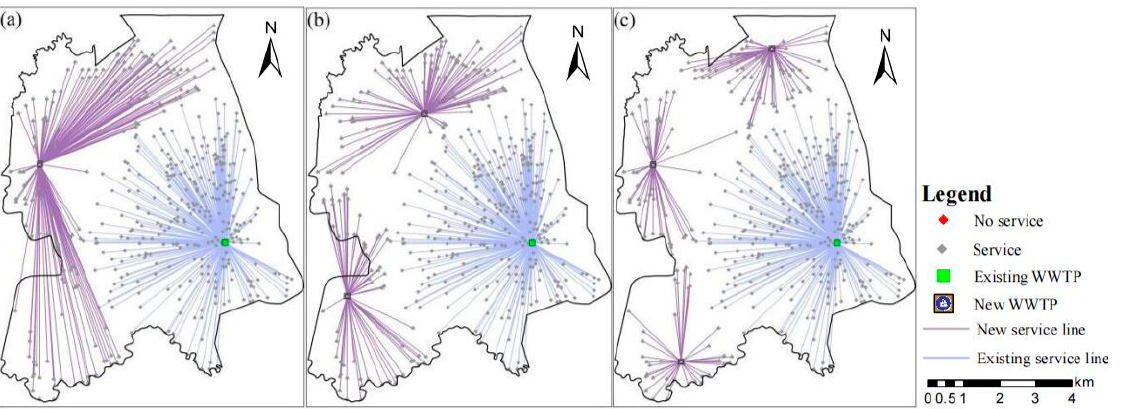
Figure 12. Distribution of WWTPs of different scales: ( a ) One large factory; ( b ) Two medium factories; ( c ) Three small factories.